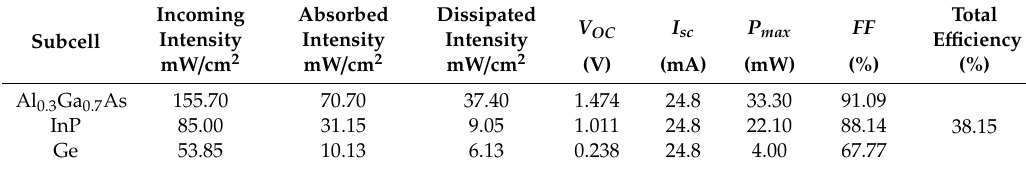
Table 3. Simulation results of TJSC at the geosynchronous orbit of